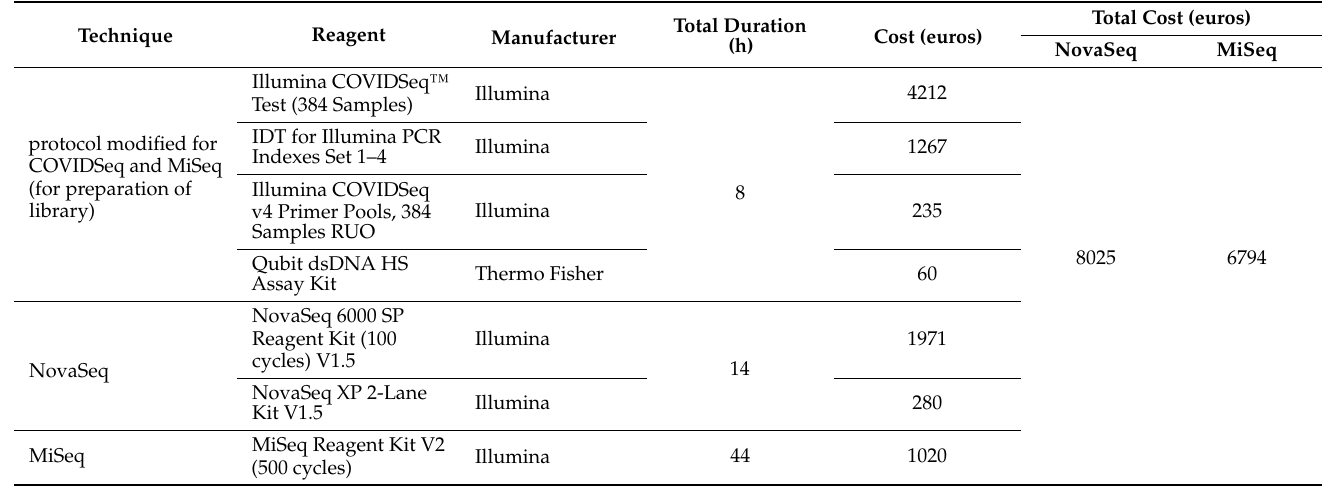
Table 3. Comparison of financial costs and required estimated time for two sequencing